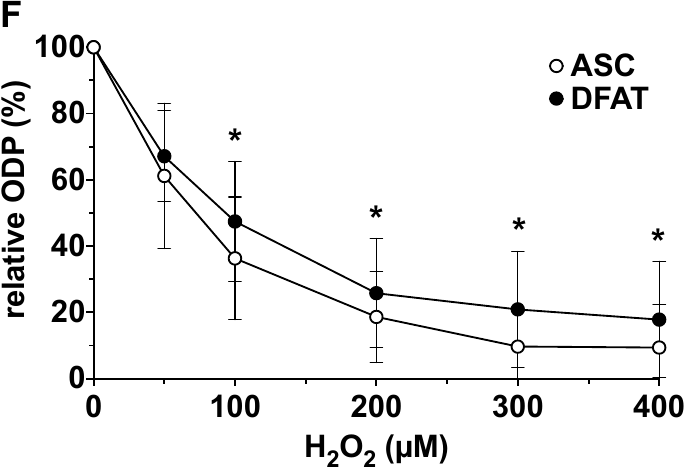
Figure 4. Impact of oxidative stress on osteogenic differentiation potential of ASC and DFAT cultures obtained from the same adipose tissue. ( A ) Alizarin Red staining of osteogenically activated ASC and DFAT cultures at day 7 and day 14 of differentiation (control) and respective cell cultures additionally maintained in the presence of 100 µ M H 2 O 2 (H 2 O 2 ), scale bars 200 µ M. ( B ) Quantitative evaluation of the osteogenic differentiation potential (ODP) of osteogenically activated ASC (white box) and DFAT cultures (grey box) and respective cell cultures additionally maintained in the presence of 100 µ M H 2 O 2 . (+H 2 O 2 ). The ODP values at day 14 of differentiation of 9 individual ( n = 9) ASC or DFAT cultures are shown as boxplot with median value and with whiskers with minimum and maximum. As measurement parameter of the respective ODP value we used of the optical density of the Alizarin Red redissolution at 600 nm (OD 600 ) of the cultures indicated. *, p < 0.05 as compared to the respective control culture maintained in the absence of H 2 O 2 . ( C ) Individual ODP values of the ASC cultures examined in ( B ) (ASC control cultures, white circles; H 2 O 2 -treated ASC cultures, black circles). ( D ) Individual ODP values of the DFAT cultures examined in ( B ) (DFAT control cultures, white circles; H 2 O 2 -treated DFAT cultures, black circles). ( E ) Relative decrease in ODP reduction at day 14 of differentiation after 14 day treatment with 100 µ M H 2 O 2 . ASC (white box), DFAT cultures (grey box). ( C – E ), * p < 0.05. n = 9. ( F ) Change in the ODP of ASC (white circles) and DFAT cultures (black circles) detected at day 14 of differentiation after 14 day treatment with H 2 O 2 at concentration indicated. * p < 0.05 as compared to the respective ASC cultures. n =